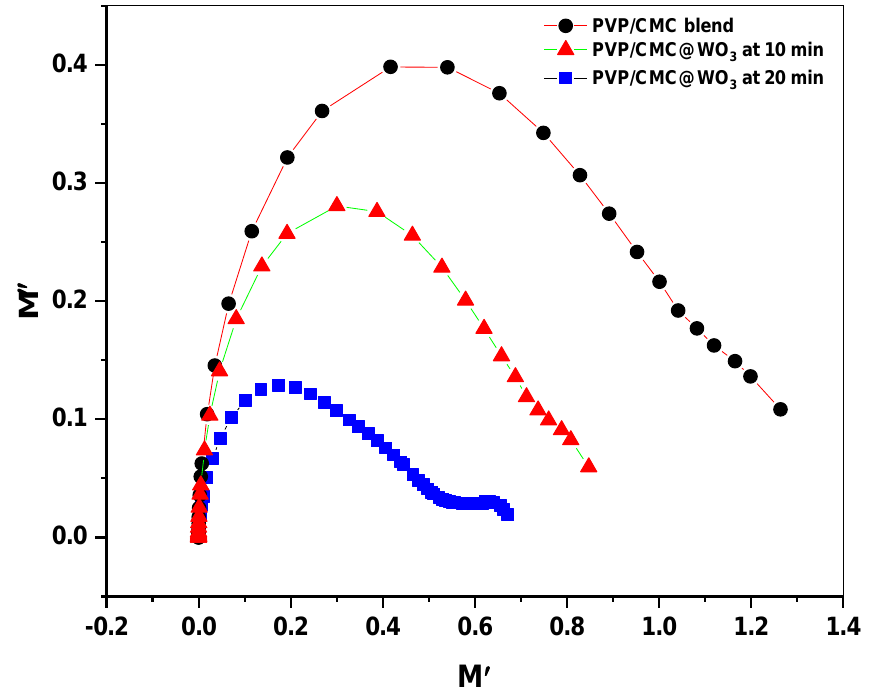
Figure 8. Argand plot of PVP/CMC and PVP/CMC -WO 3 at two laser-ablation times (10 and 20 min).